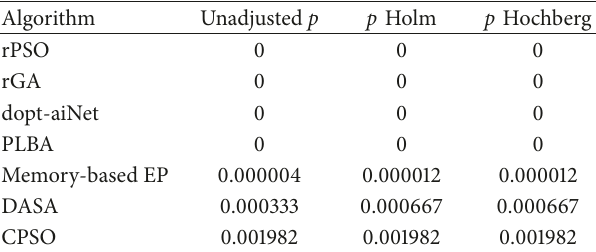
Table 16: Adjusted 𝑝 values associated with PLBA and other algorithms (Friedman) on dynamic benchmark problems 𝐹 1 – 𝐹 6 in terms of the solution quality.